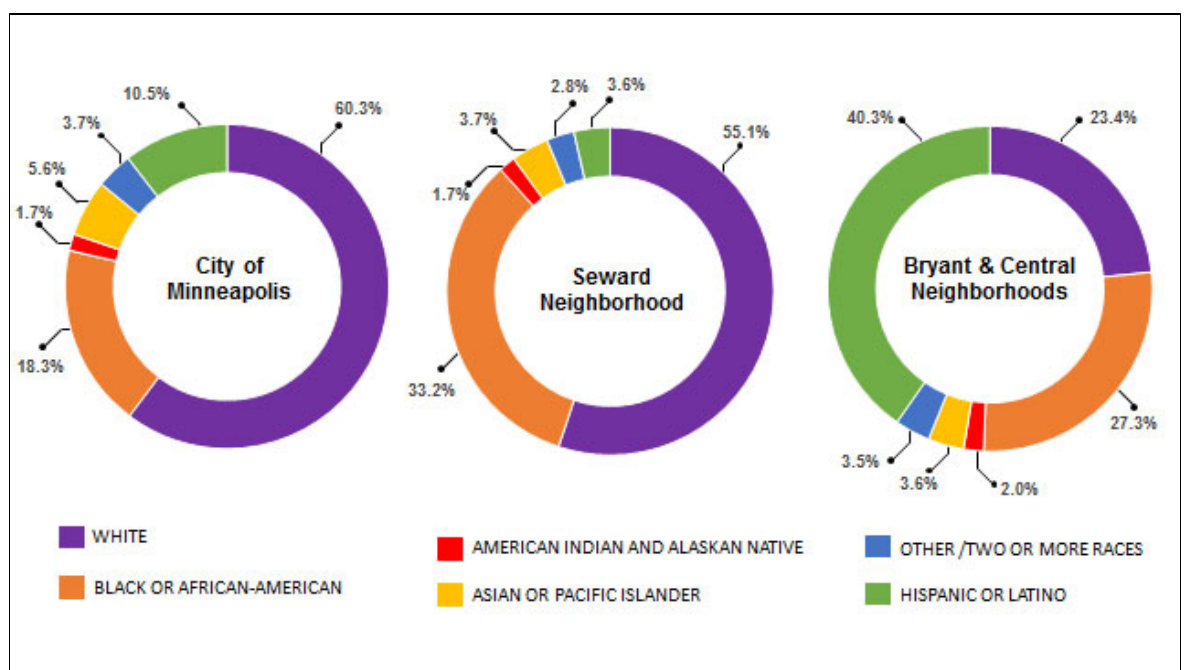
Figure 3. Comparative Racial Makeup of Minneapolis, Seward Neighborhood, and Bryant/Central Neighborhoods, Based on Data from the 2010 Census